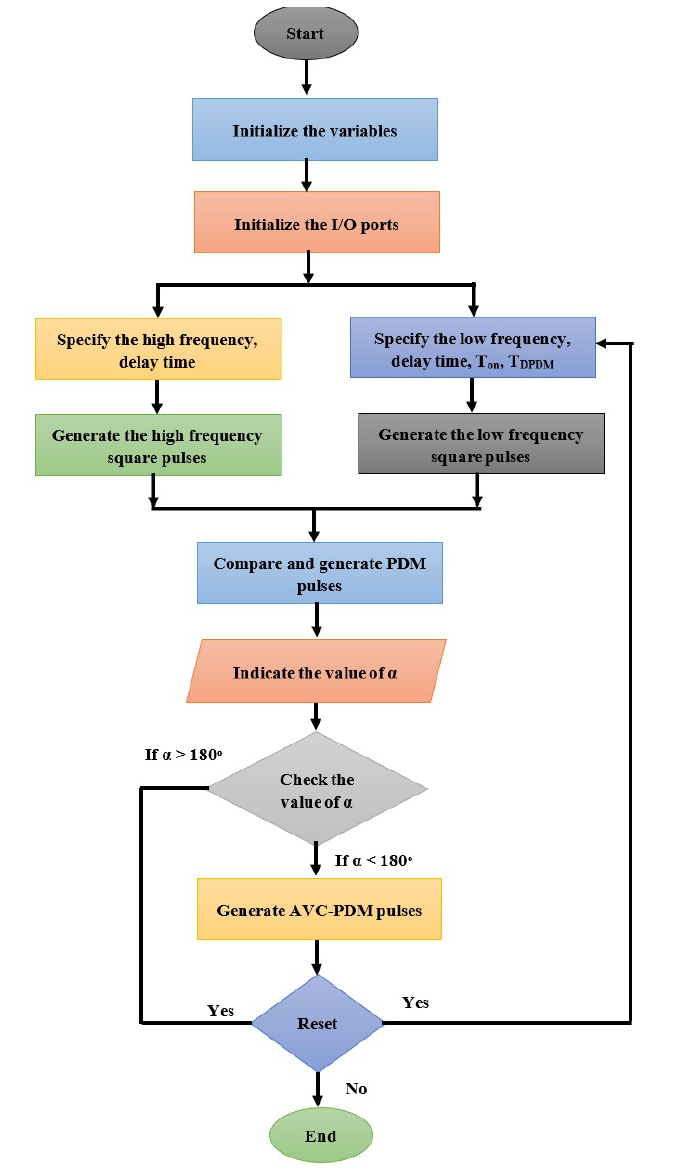
Figure 19. Flow chart for AVC-PDM control technique.